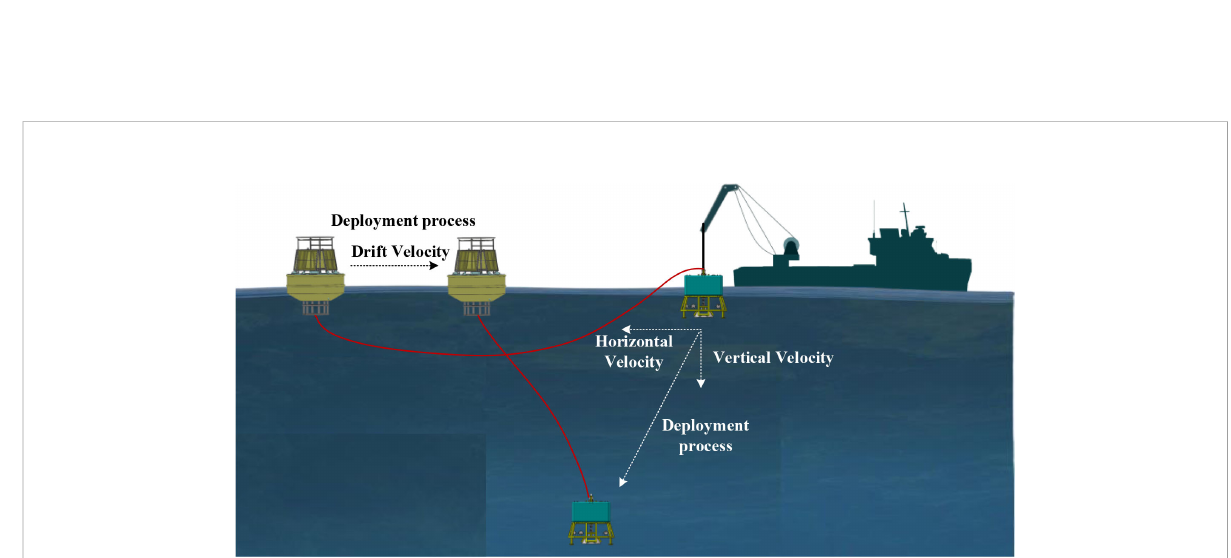
FIGURE 13 Motion of the buoy, mooring line, and benthic node during system launch.